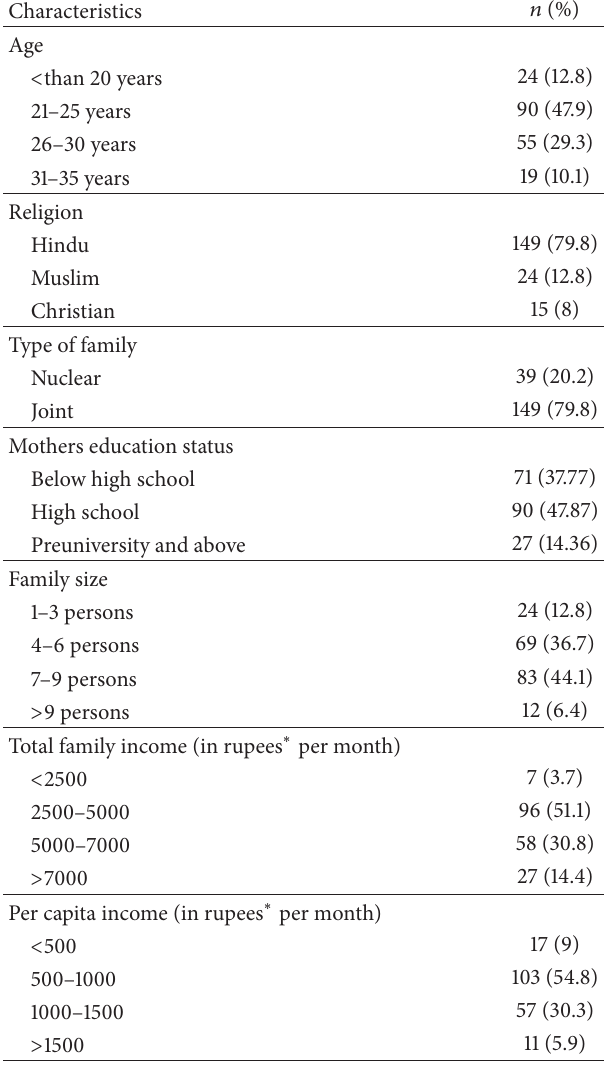
Table 2: Breastfeeding practices among lactating mothers in the current pregnancy ( 𝑁 = 188